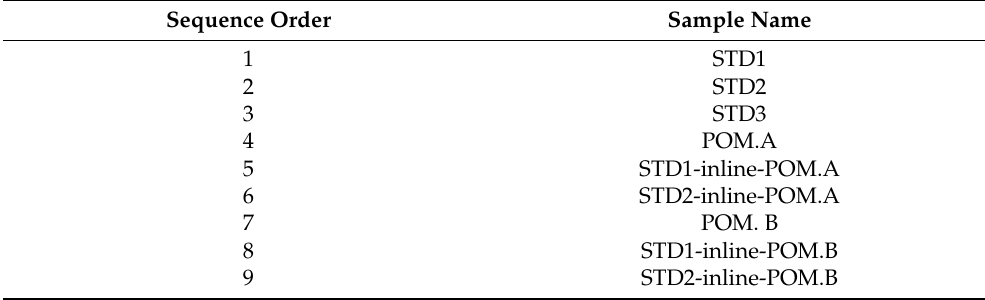
Table 1. Executed HPLC sequence for the quantification of pomegranate molasses samples. Sequence Order